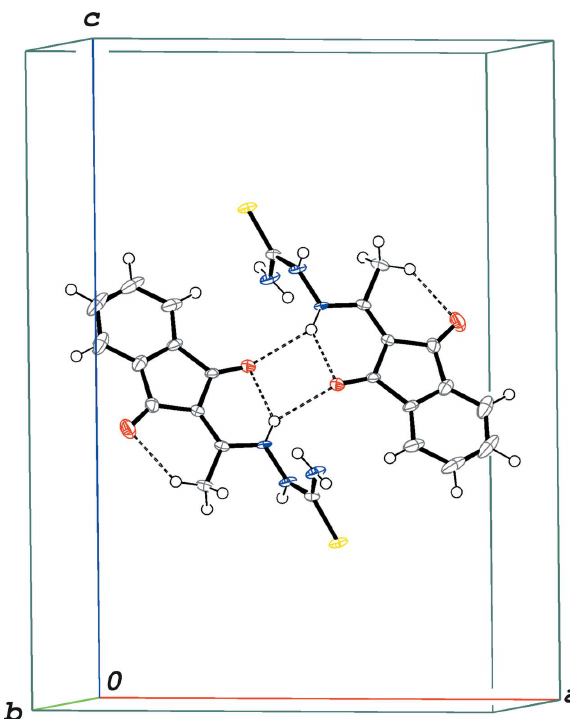
Figure 2 The inversion dimer of the title compound formed by a pair of N—H (cid:3)(cid:3)(cid:3) O hydrogen bonds (dashed lines).